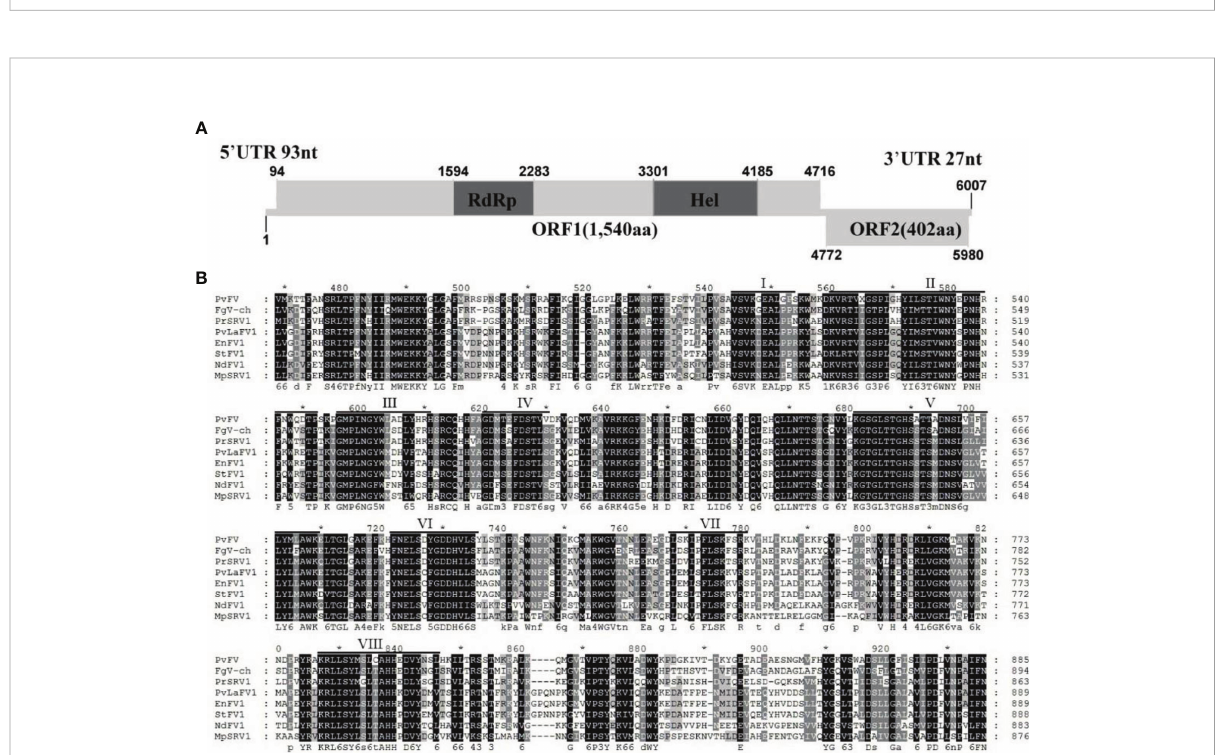
FIGURE 8 Diagrammatic representation of the genome organization and multiple alignment of PvFV1. (A) Schematic representation of the PvFV1 genome organization, which contained a single open reading frame (ORF) encoding a putative RNA-dependent RNA polymerase (RdRp) and 5 ’ and 3 ’ untranslated regions (UTRs). (B) Multiple alignment of the aa sequences of the RdRp domains of PvFV1 and other similar Fusariviruses using the ClustalX program and highlighted using the GeneDoc program. The conserved motifs in these RdRps are indicated by Roman numerals I to VIII. Virus names and accession numbers are as follows: FgV-ch, Fusarium graminearum dsRNA mycovirus-1 (AAT07067.2); PrSRV1, Penicillium roqueforti ssRNA mycovirus 1 (AII99895.1); PvLaFV1, Plasmopara viticola lesion associated fusarivirus 1 (QHD64725.1); EnFV1, Erysiphe necator - associated fusarivirus 1 (QHD64833.1); StFV1, Setosphaeria turcica fusarivirus 1 (QRI93681.1); NdFV1, Neurospora discreta fusarivirus 1 (BCL64192.1); MpSRV1, Macrophomina phaseolina single-stranded RNA virus 1 (ALD89094.1).